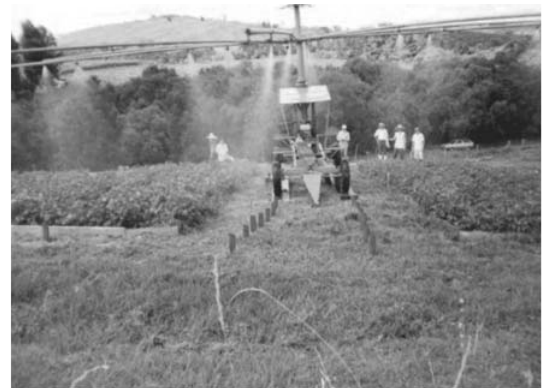
Figura 1. Parcela experimental de erosão sob chuva